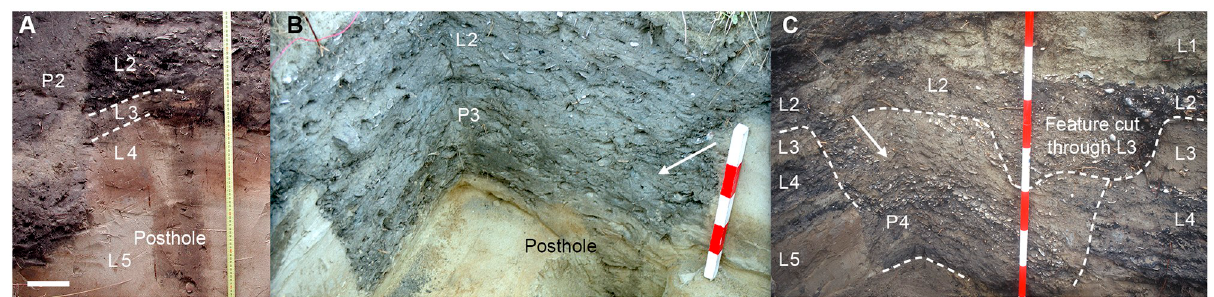
Fig 3. Section images from excavated pits, I44/21 S (referenced from Fig 2). Arrows indicate oblique angle of fill lenses and associated mollusc valve orientation. Unit codes follow S1 Table. (A) Northern edge of P2 truncating L2 beside external posthole (text over fill), image in perpendicular view; scale bar 10 cm. (B) Western P3 edge, unit corner and internal posthole (text mainly left of fill), oblique view; scale increment 5 cm. (C) Southeastern P4 edge, unit corner, oblique view; scale increment 20 cm.